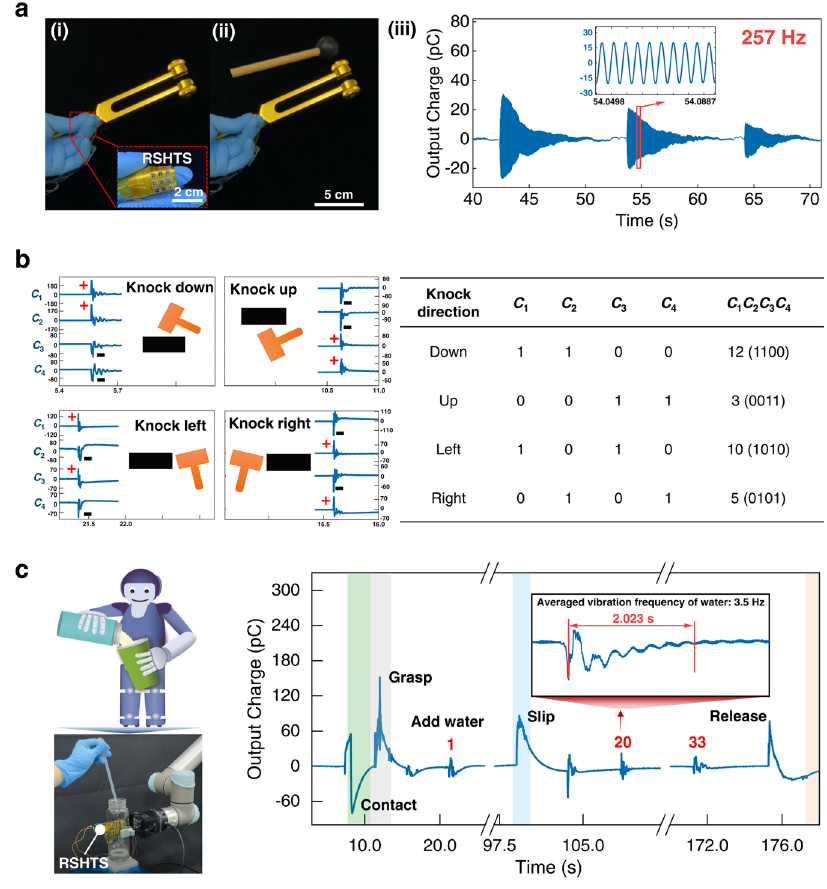
Fig. 4 | High-frequency stimuli detection of the RSHTS and RSHTS-based robotichandtodetectimpactforce,andsimulaterobotpouringwater.a High- frequency waveforms generated by tuning forks are recorded by the RSHTS attached to the human fi nger. Other high-frequency waveforms are shown in Supplementary Fig. 19. b The real-time output charge of four piezoelectric capa- citors, from which the knock directions can be determined. Here, the positive and negative peaks of C 1 , C 2 , C 3 , and C 4 are labeled to binary values of 1 and 0, respectively. Thus, the decimalvalue of C 1 C 2 C 3 C 4 can be usedto present the knock